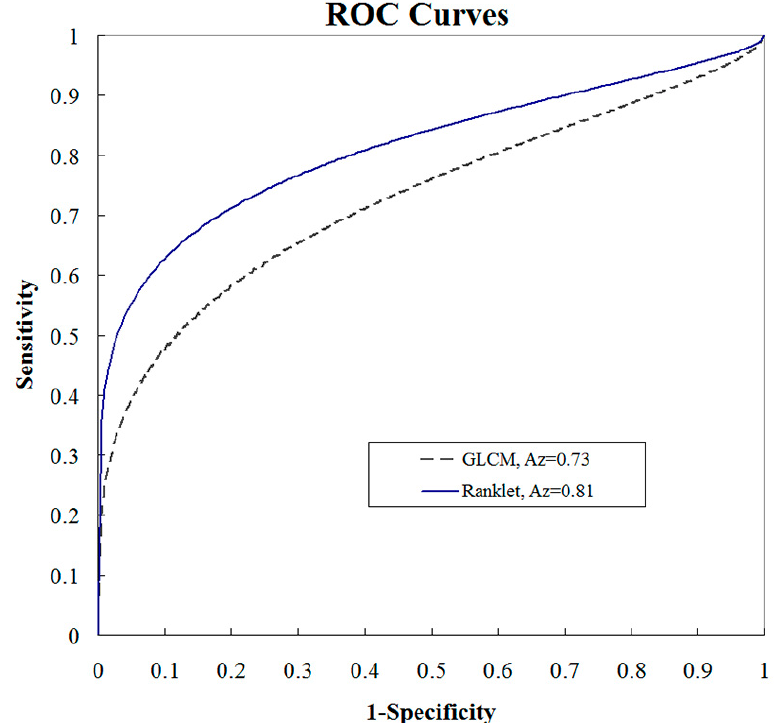
Figure 4. Receiver operating characteristic (ROC) curves of the gray level co-occurrence matrix (GLCM) and Ranklet features regarding trade-offs between sensitivity and specificity.